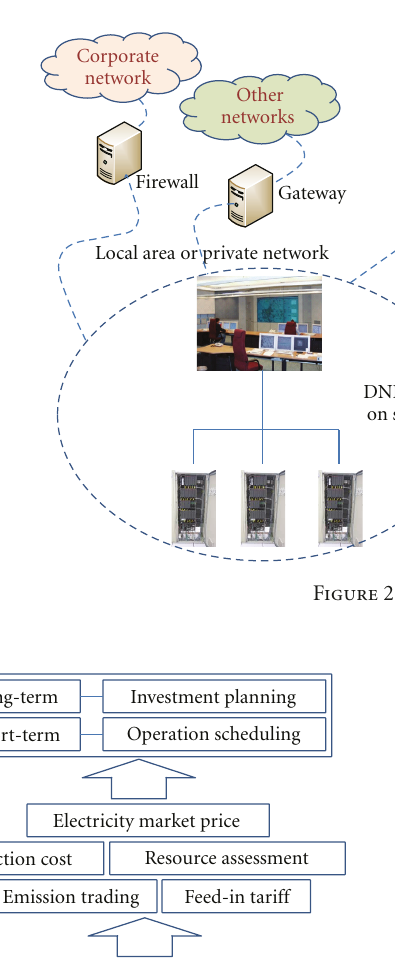
Figure 1: Evolution from SCADA system to Smart Grid.